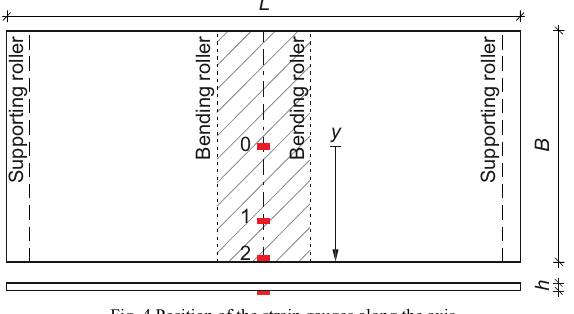
Fig. 4 Position of the strain gauges along the axis.